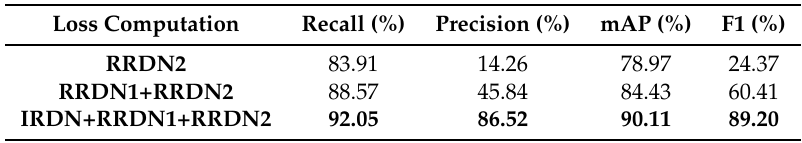
Table 3. Experimental results of multi-stage loss